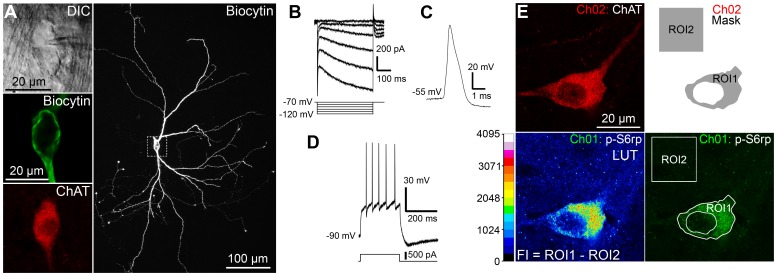
Cellular physiology and S6rp phosphorylation in CINs from viable striatal slices.(A) A representative striatal ChAT-immunoreactive neuron labeled with biocytin during electrophysiological recording. Visualization of the neuron after difference interference contrast (DIC) illumination (top left A), post hoc single optical scan of biocytin (middle left A) and ChAT labeling (bottom left A), and confocal Z stack projection of biocytin labeling at low magnification (20×, right A). (B–D) Cellular physiological characteristics of the neuron in A under whole-cell patch-clamp. Current-voltage relationship recorded by stepping the cell to various hyperpolarizing membrane potentials (B). Under current-clamp configuration, whole-cell action potential (C) and depolarization-triggered action potential firing (D) were routinely sampled for comparisons with known CIN cellular characteristics. (E) Quantification of p-S6rp in a ChAT-immunoreactive neuron from a viable striatal slice after overnight fixation and immunofluorescence. The neuron was identified under the microscope and a high magnification optical section was taken sequentially (Ch01: p-Ser240–244S6rp; Ch02: ChAT). Fluorescence intensity (FI) of the phospho-S6rp signal in each neuron was studied by defining an image mask in Ch02 (ROI1: somatic area; ROI2: background in 15 um2 in the vicinity of the soma) and superimposing it onto Ch01. The mean gray value of the pixels contained in ROI1 and ROI2 was obtained for Ch01, and FI was defined as ROI1 minus ROI2. A 16 pseudo-color palette (Lookup Table, LUT) applied in Ch01 highlights the intensity of p-S6rp fluorescence. The LUT scale defines 16-color intervals according to pixel gray values in a 16-bit image.